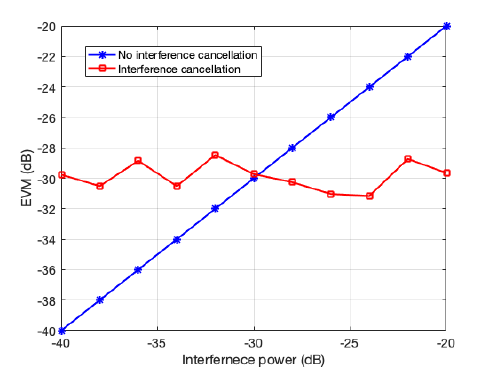
Figure 9. Error vector magnitude (EVM) performance with and without interference cancellation depending on interference